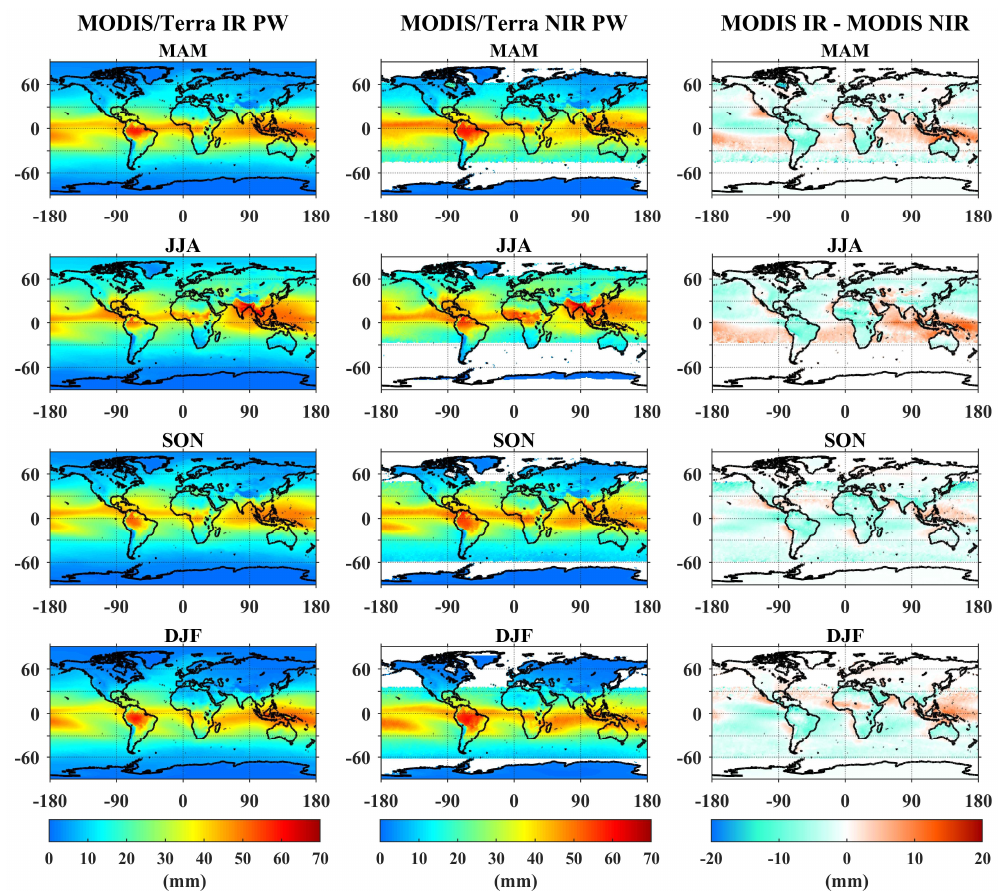
Figure 1. Maps of precipitable water (PW) from (left) the Moderate Resolution Imaging Spectroradiometer (MODIS) infrared (IR) and (middle) MODIS near-IR (NIR) observations, and (right) their differences for the four seasons (top to bottom) for 2000–2014.